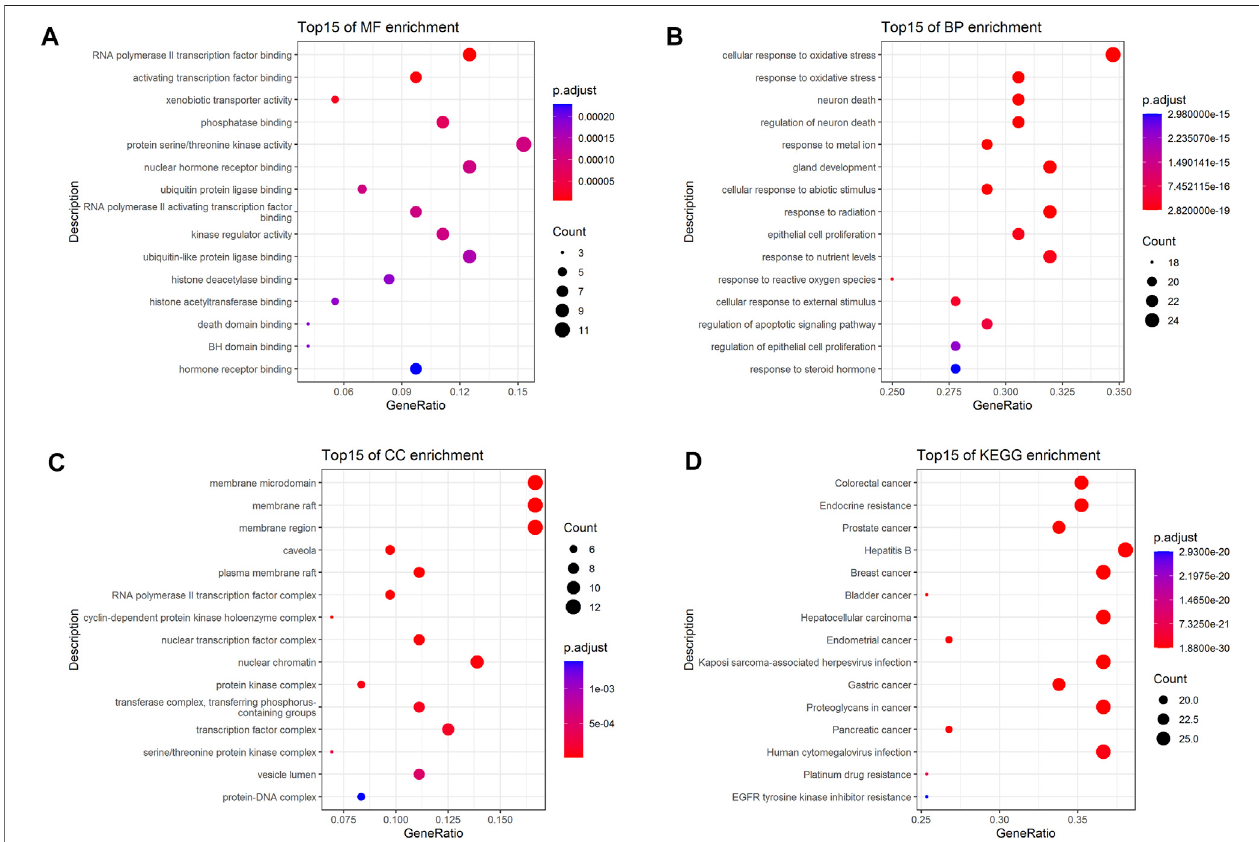
FIGURE 3 | GO and KEGG enrichment analysis. (A) Top 15 signi fi cantly enriched terms in molecular function (MF); (B) Top 15 signi fi cantly enriched terms in biological process (BP); (C) Top 15 signi fi cantly enriched terms in cellular component (CC); (D) Top 15 signi fi cantly enriched terms in the KEGG pathway. Gene ratio = count/set size.